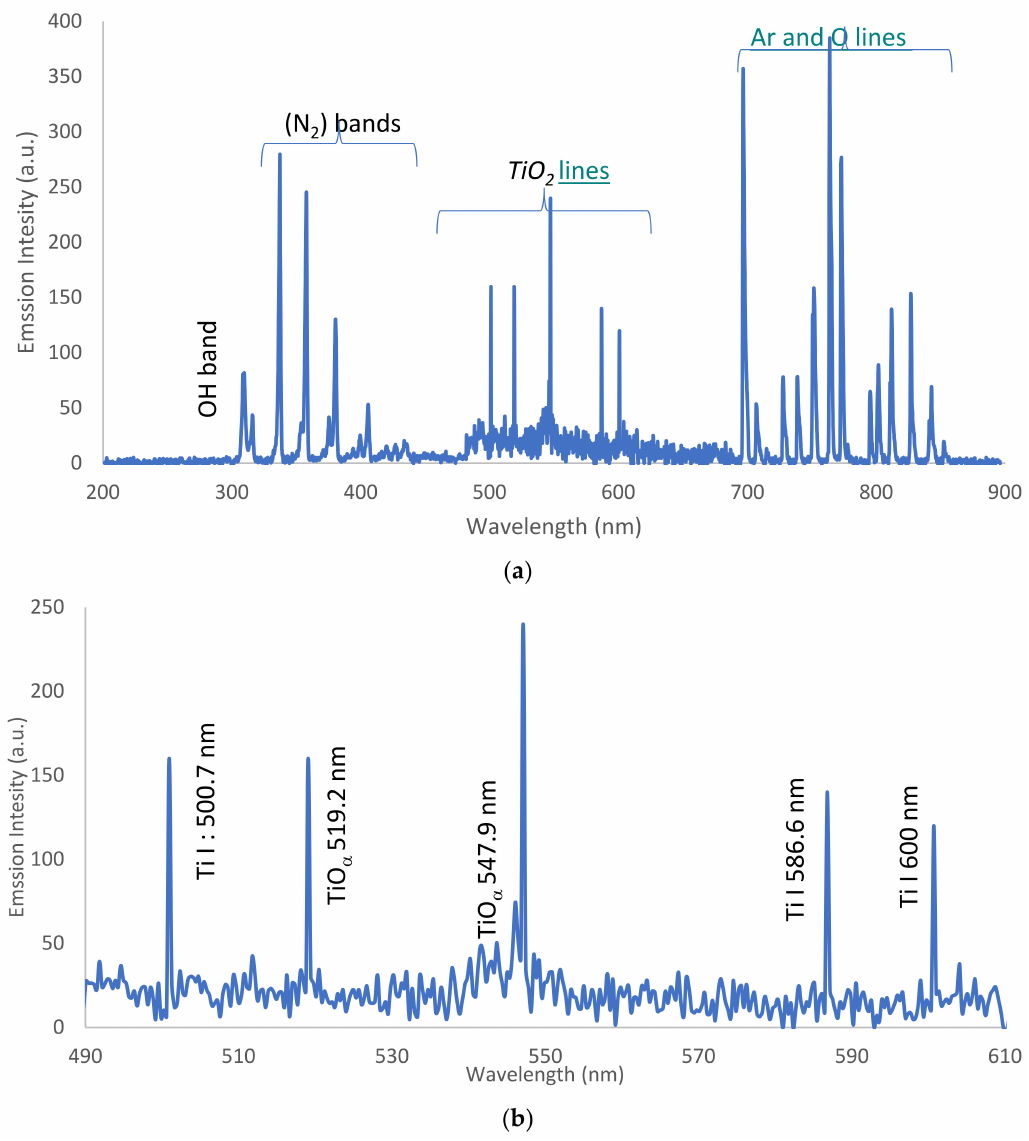
Figure 5. ( a ) Intensity of emission spectra versus wavelength for wet argon discharge. ( b ) Intensity of emission spectra versus wavelength for TiO 2